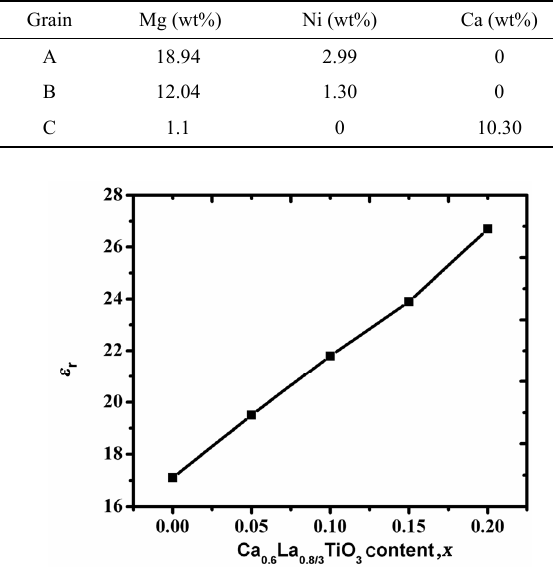
Fig. 5 of (1 − x )Mg 0.95 Ni 0.05 Ti 0.98 Zr 0.02 O 3 – x Ca 0.6 - Q f Fig. u 0 La 0.8/3 TiO 3 (0 ≤ x ≤ 0.2) ceramics as a function of x value.